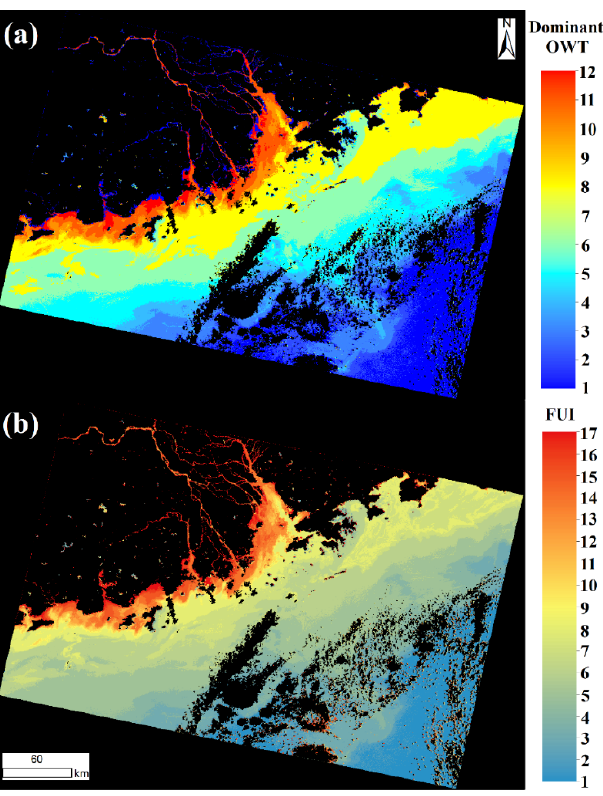
Figure 14. The ( a ) U-OWT dominant OWT and the ( b ) FUI spatial distributions of the Sentinel-3A OLCI image taken overpassing the Pearl River Estuary on 23 October 2017. The land and cloud pixels are masked.